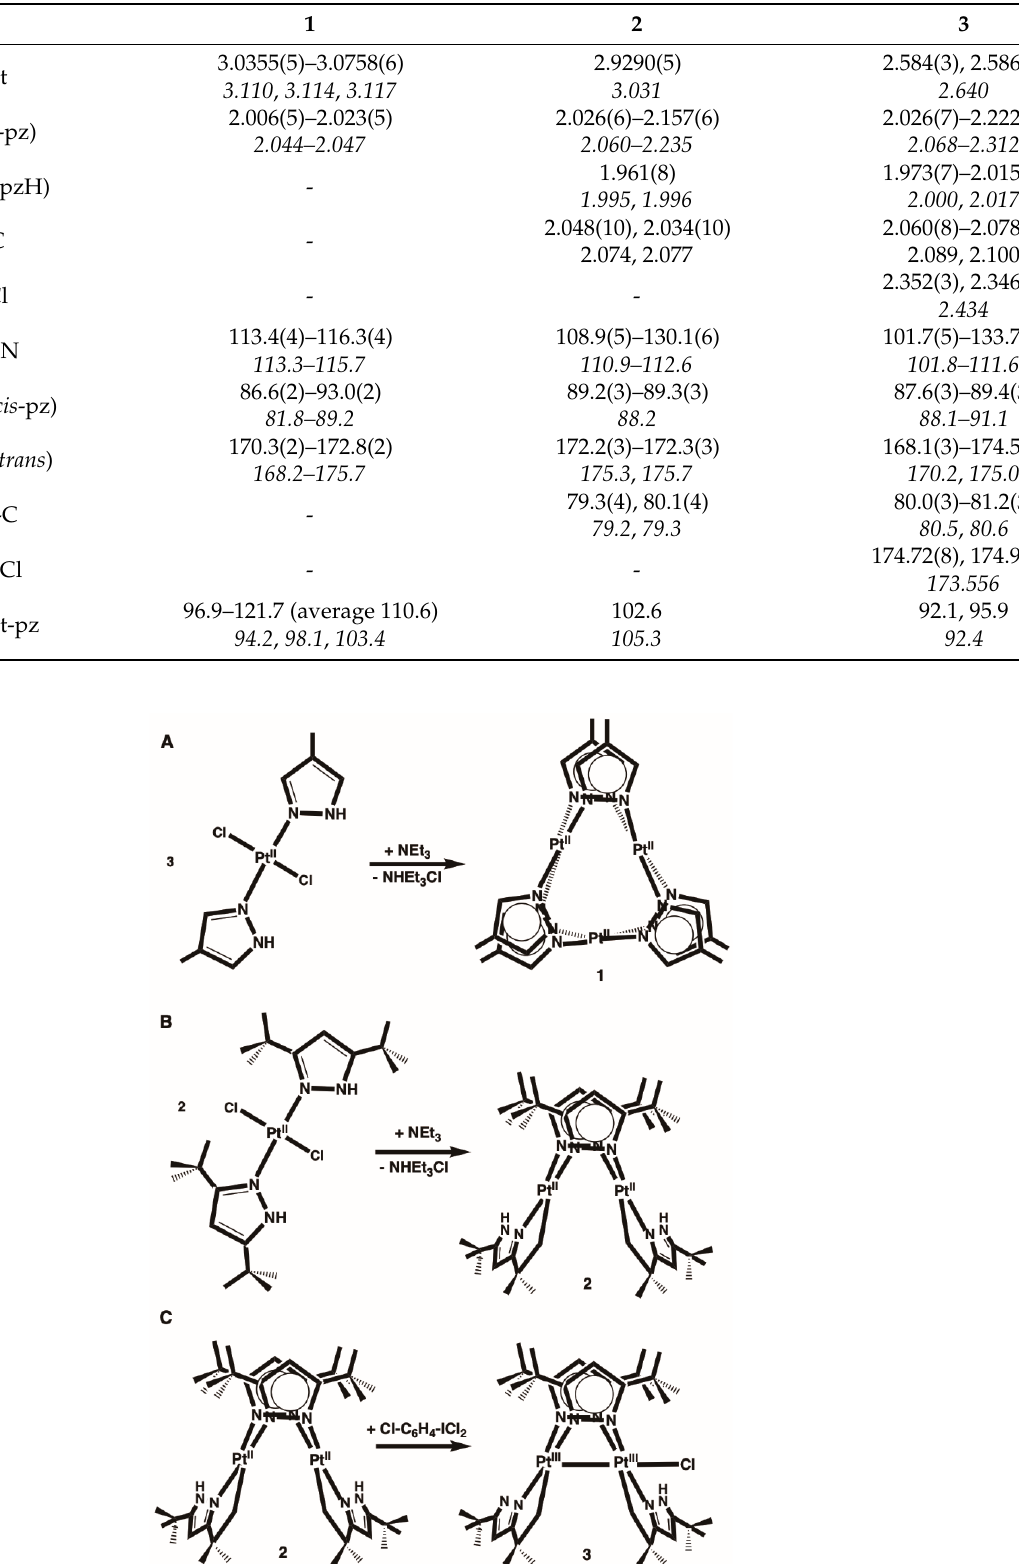
Table 1. Selected experimental and calculated distances (Å) and angles ( ◦ ) for 1 , 2, and 3 , calculated data in italics.